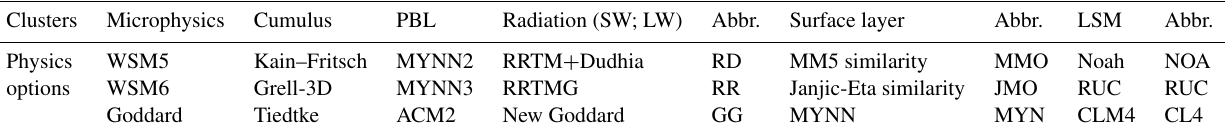
Table 2. Employed physics configuration of Set 2, which summarized 3 × 3 × 3 × 19 configurations. Both revised MM5 MO (MMO) and Janjic-Eta MO (JMO) similarity is based on Monin–Obukhov similarity, and therefore, we use MO to represent the abbreviation. Clusters